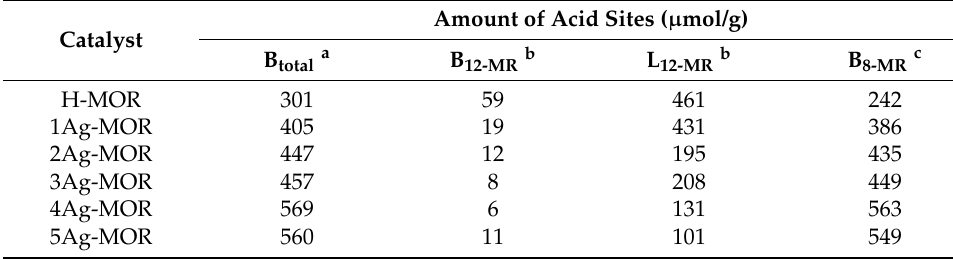
Figure 9. CO ‐ TPD spectra of the catalysts.